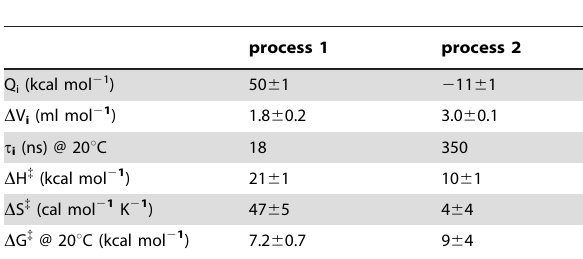
Table 2. Estimated released heat Qi, structural volume change D Vi, and activation parameters, obtained from the plots in Fig. 5